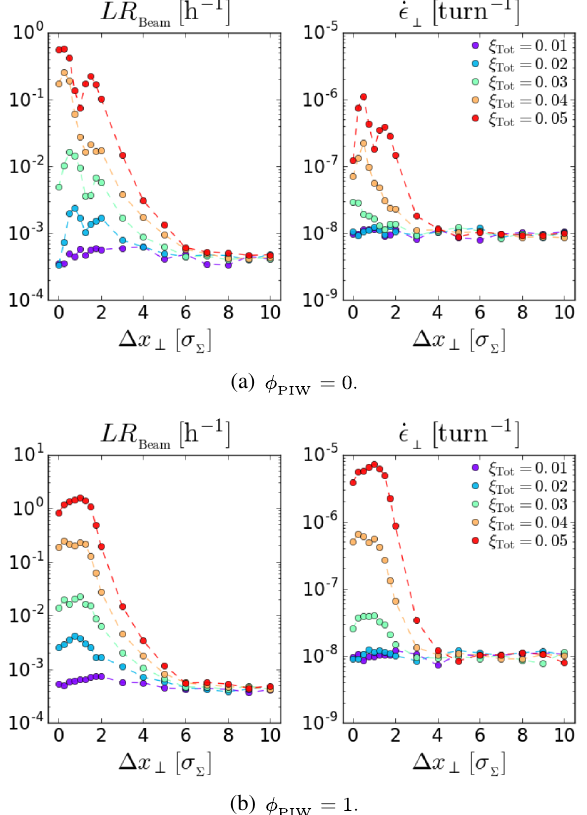
FIG. 12. Beam quality reduction for multiple combinations of a transverse separation at the IPs, Δ x ⊥ , and ξ Q